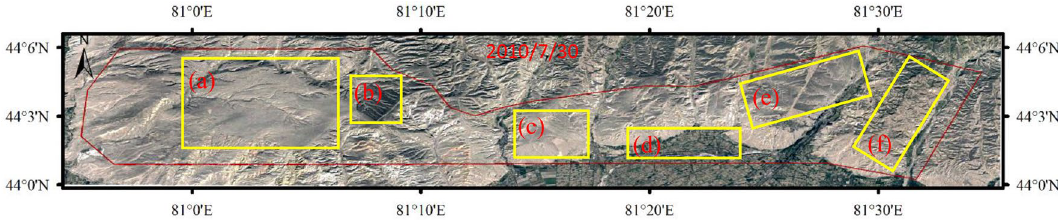
Figure 12. Google satellite image of Ibei coalfield before mining. The Figure is created using Google Earth Pro ver.7.3.4 (http:// www. googl ediqiu. com/).